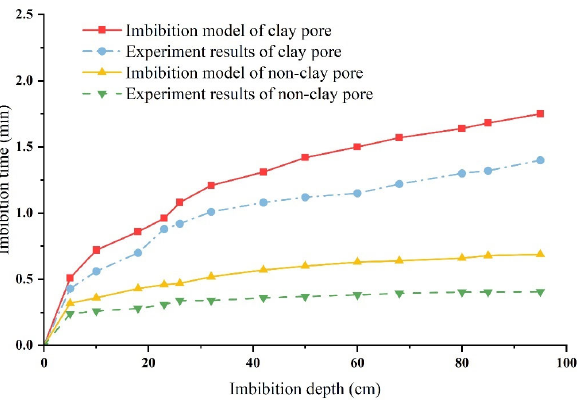
Figure 14. Comparison of experimental and theoretical model results.